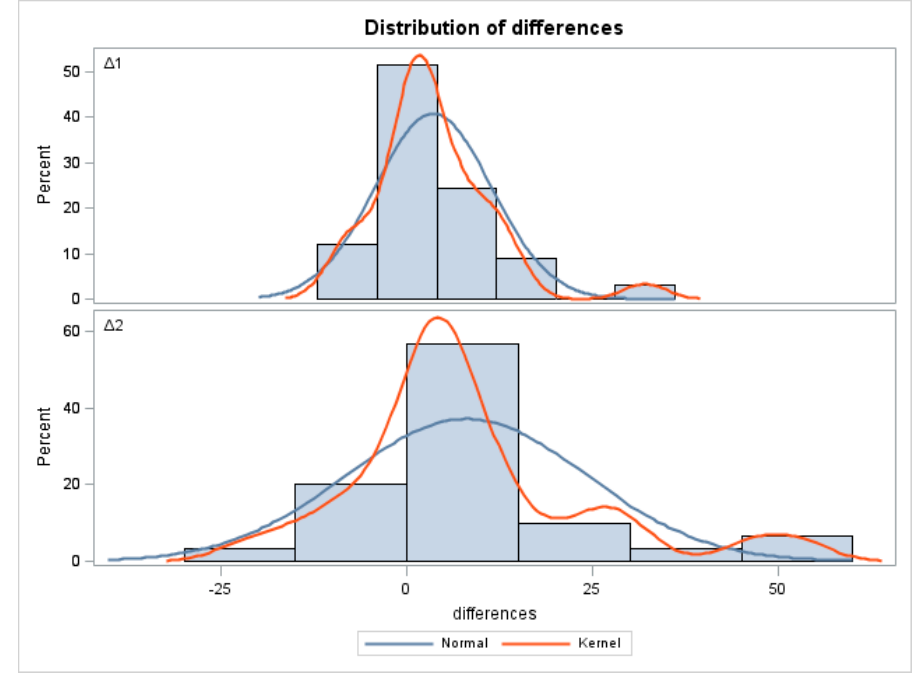
Figure 2. Distribution of ∆ M values. Histograms and corresponding density estimators for the differences between methods are displayed. The upper panel represents ∆ 1, the difference between LD-PCR and pyrosequencing, and the bottom panel reflects ∆ 2, the difference between LD-PCR and NGS on the Miseq platform. The values determined by LD-PCR and pyrosequencing showed greater similarity than those obtained by LD-PCR and Miseq-NGS. The normal density (blue line) clearly shows greater variance for ∆ 2 in comparison to ∆ 1. Table 3. Comparison of quantitative mutant subclone assessment using different methods. Overview of results obtained by pairwise comparison of measurements by LD-PCR, pyrosequencing, and NGS